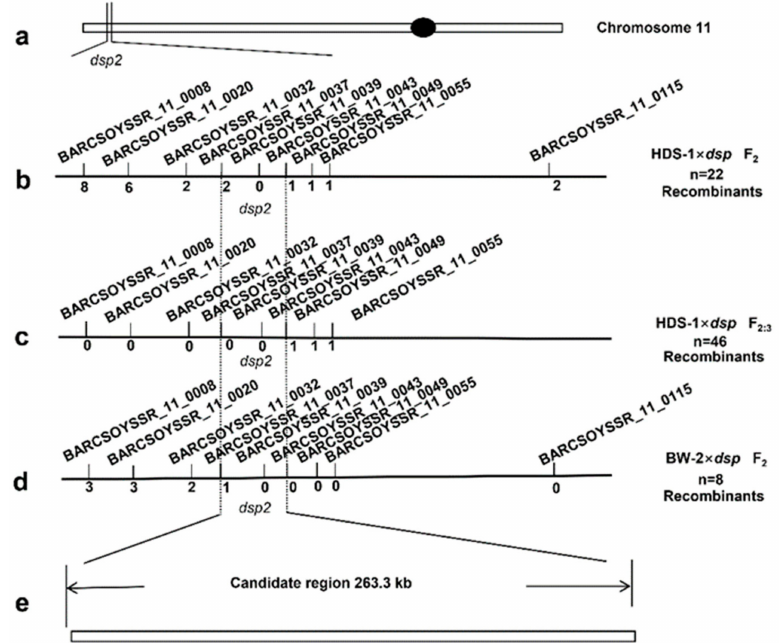
Figure 3. Mapping of the dsp2 locus. ( a – d ) Two F 2 populations of HDS-1 × dsp ( b ) and BW-2 × dsp ( d ) were used here. One F 2:3 population derived from dsp1dsp1Dsp2dsp2 F 2 plants of HDS-1 × dsp was used to verify the mapping result of dsp2 ( c ). The dsp2 locus was mapped between BARCSOYSSR_11_0037 and BARCSOYSSR_11_0043, a 263.3-kb region in the front end of chromosome 11 ( e ). Black spot represents centromere. Number below every SSR marker means recombinant individual